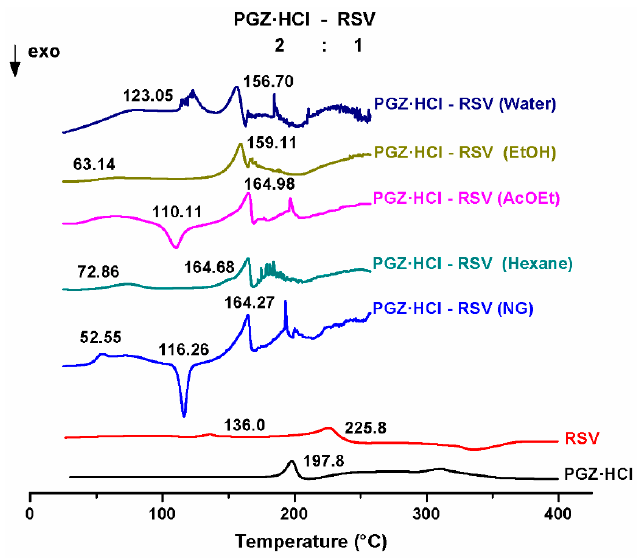
Figure 2. DSC thermograms of the solid phases of PGZ · HCl-RSV (2:1) prepared by NG or LAG solvent-screening.